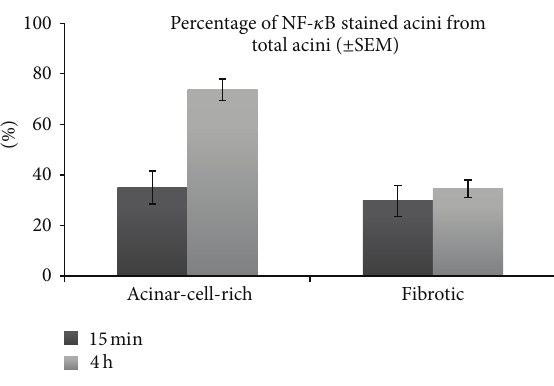
Figure 3: Comparison of NF- 𝜅 B activation in acinar-cell-rich and fibrotic pancreata. The means ( ± SEM) of the three acinar-cell-rich and the three fibrotic samples were calculated and then compared at 15 minutes and 4 hours. In acinar-cell-rich pancreata, a significant increase in NF- 𝜅 B expression occurs between 15 minutes (35%) and 4 hours (74%). In fibrotic pancreata, the change between 15 minutes (30%) and 4 hours (35%) is minor.